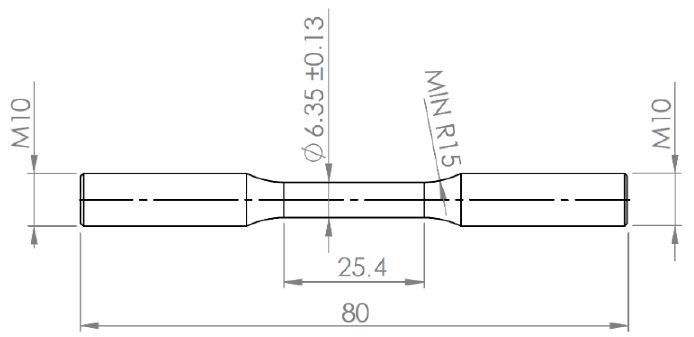
Figure 4. Specimen geometry with reference to NACE TM0177.